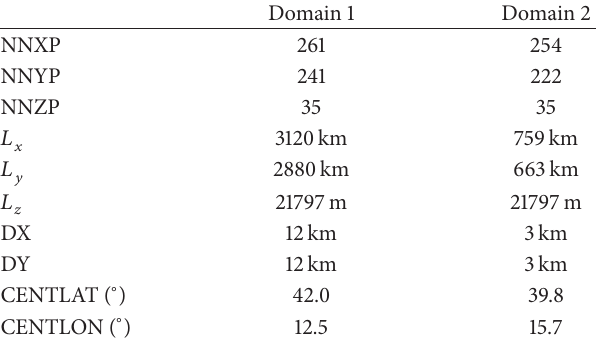
Table 1: RAMS grid-setting. NNXP, NNYP, and NNYZ are the number of grid points in the west-east, north-south, and vertical directions. 𝐿 𝑥 (km), 𝐿 𝑦 (km), and 𝐿 𝑧 (m) are the domain extension in the west-east, north-south, and vertical directions. DX (km) and DY (km) are the horizontal grid resolutions in the west-east and north-south directions. CENTLON and CENTLAT are the geographical coordinates of the grid